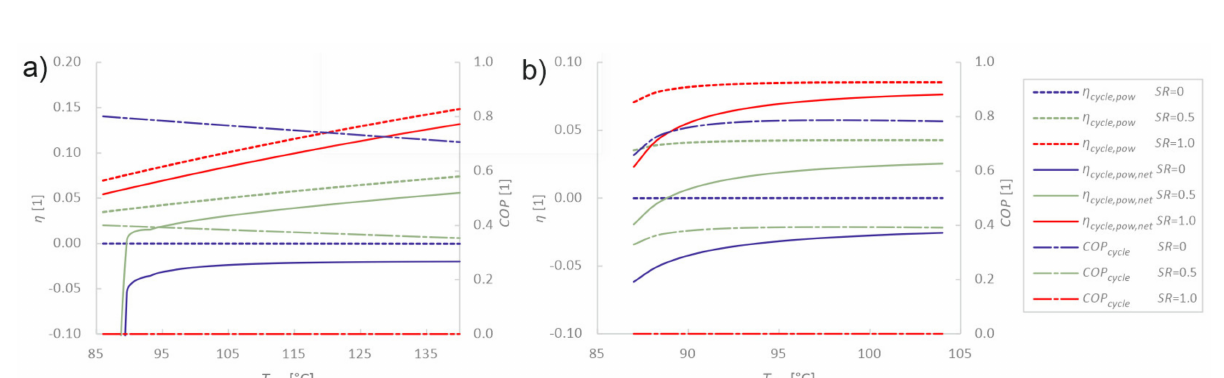
Figure A1. COP and gross and net APCC system efficiency at varied heat source temperature when ( a )